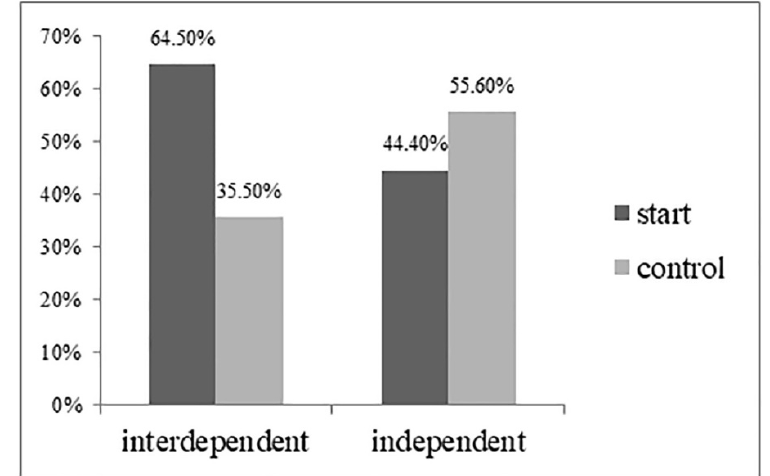
Figure 1. High ‐ arousal drink preferences (Study 1). Table 3. Statistics descriptive results in Study